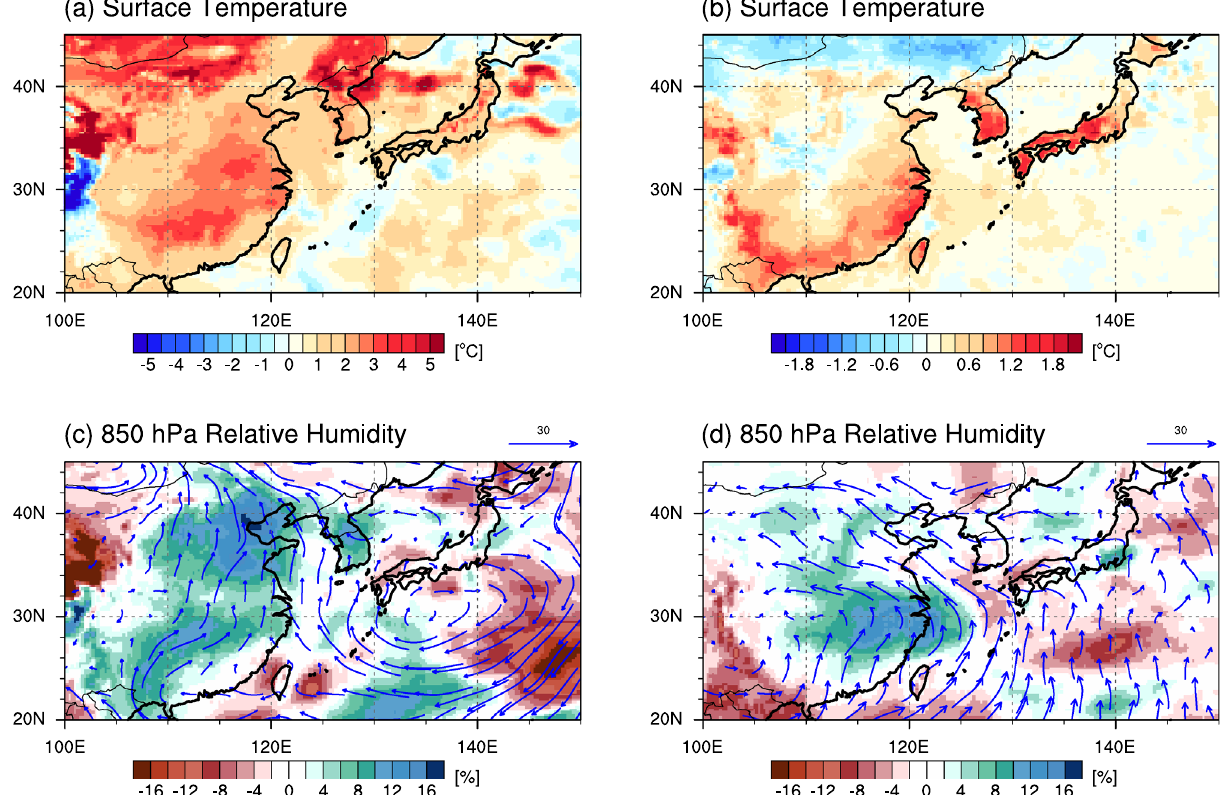
Figure 4. Difference fields between February 2020 and the February composite over years 2016–2019 (left panels) and composite mean between the week including Chinese New Year’s day and the previous week over years 2011–2020 (right panels). ( a , b ) Surface temperature and ( c , d ) relative humidity (shading) and wind (vector) at 850 hPa. The figure was generated using NCAR Command Language Version 6.5.0 (http:// dx. doi. org/ 10. 5065/ D6WD3